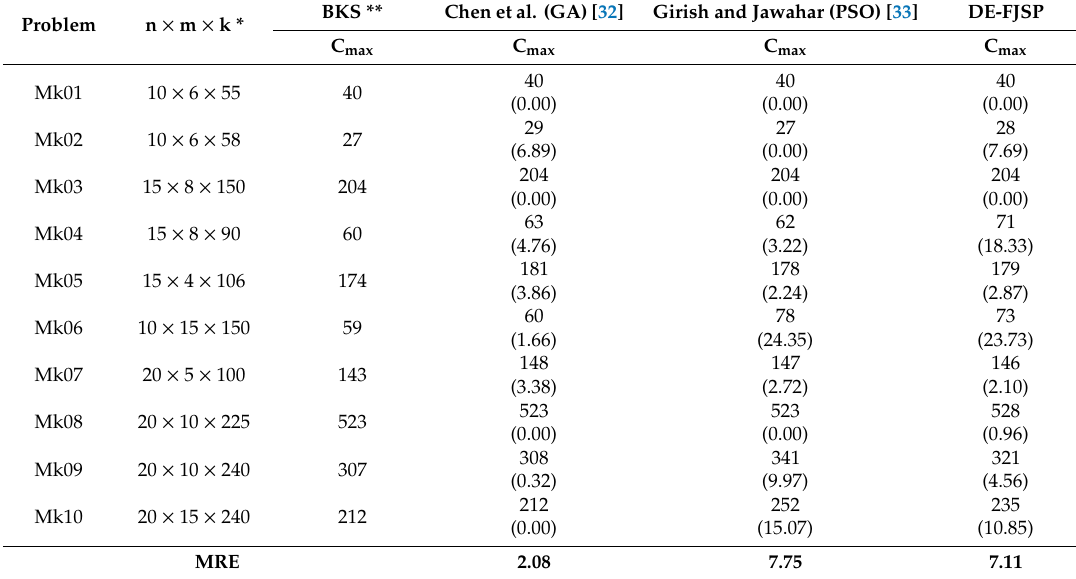
Table 17. Summary of comparing the differential evolution algorithm with other metaheuristic algorithms.